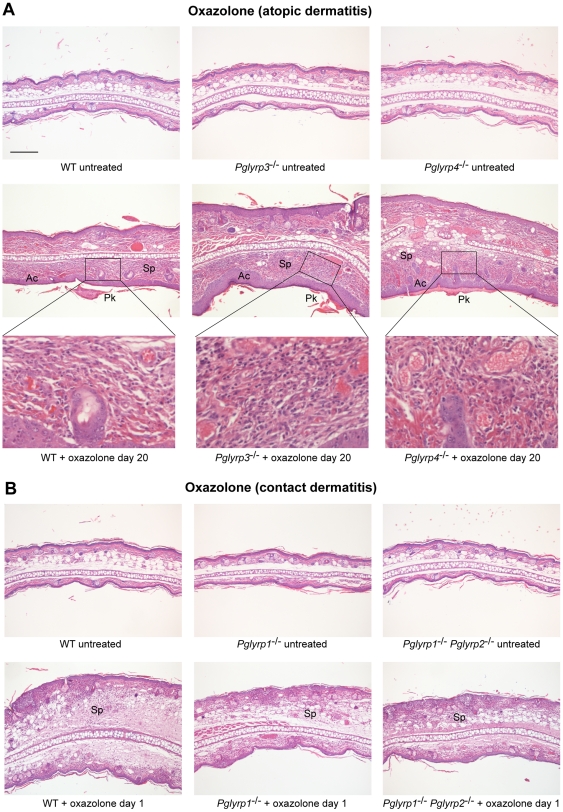
Ear histology in WT and Pglyrp-deficient mice in atopic dermatitis and contact dermatitis models of skin inflammation.(A) Oxazolone model of atopic dermatitis: sensitization and 10 applications of oxazolone to the ears every other day induced acanthosis (Ac), parakeratosis (Pk), marked thickening of the sub-epidermal layer with spongiosis (Sp) and dense cellular infiltrates of primarily mononuclear and some polymorphonuclear cells (high magnification insets), that were all highly prominent in Pglyrp3
−/− mice and Pglyrp4
−/− mice and much less severe in WT mice. (B) Oxazolone model of contact dermatitis: sensitization and a single application of oxazolone to the ears induced strong inflammatory response in WT mice with marked spongiosis of the sub-epidermal layer (Sp) and cellular infiltrates of epidermal and sub-epidermal layers, composed of mononuclear and polymorphonuclear cells; Pglyrp1
−/− and Pglyrp1
−/−
Pglyrp2
−/− mice still had cellular infiltrates, but had substantially reduced swelling, compared to WT mice, mostly due to reduced edema. H&E stained cross-sections; bar = 200 µm for all panels, except high magnification insets (the magnified areas are shown by rectangles).